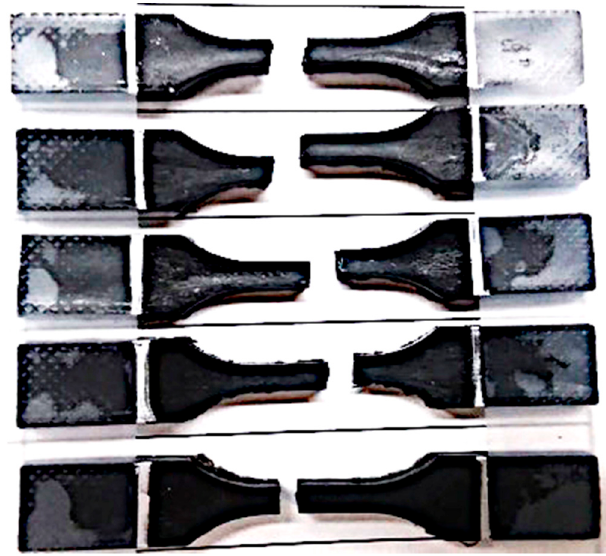
Figure 9. The failure patterns of composite samples.